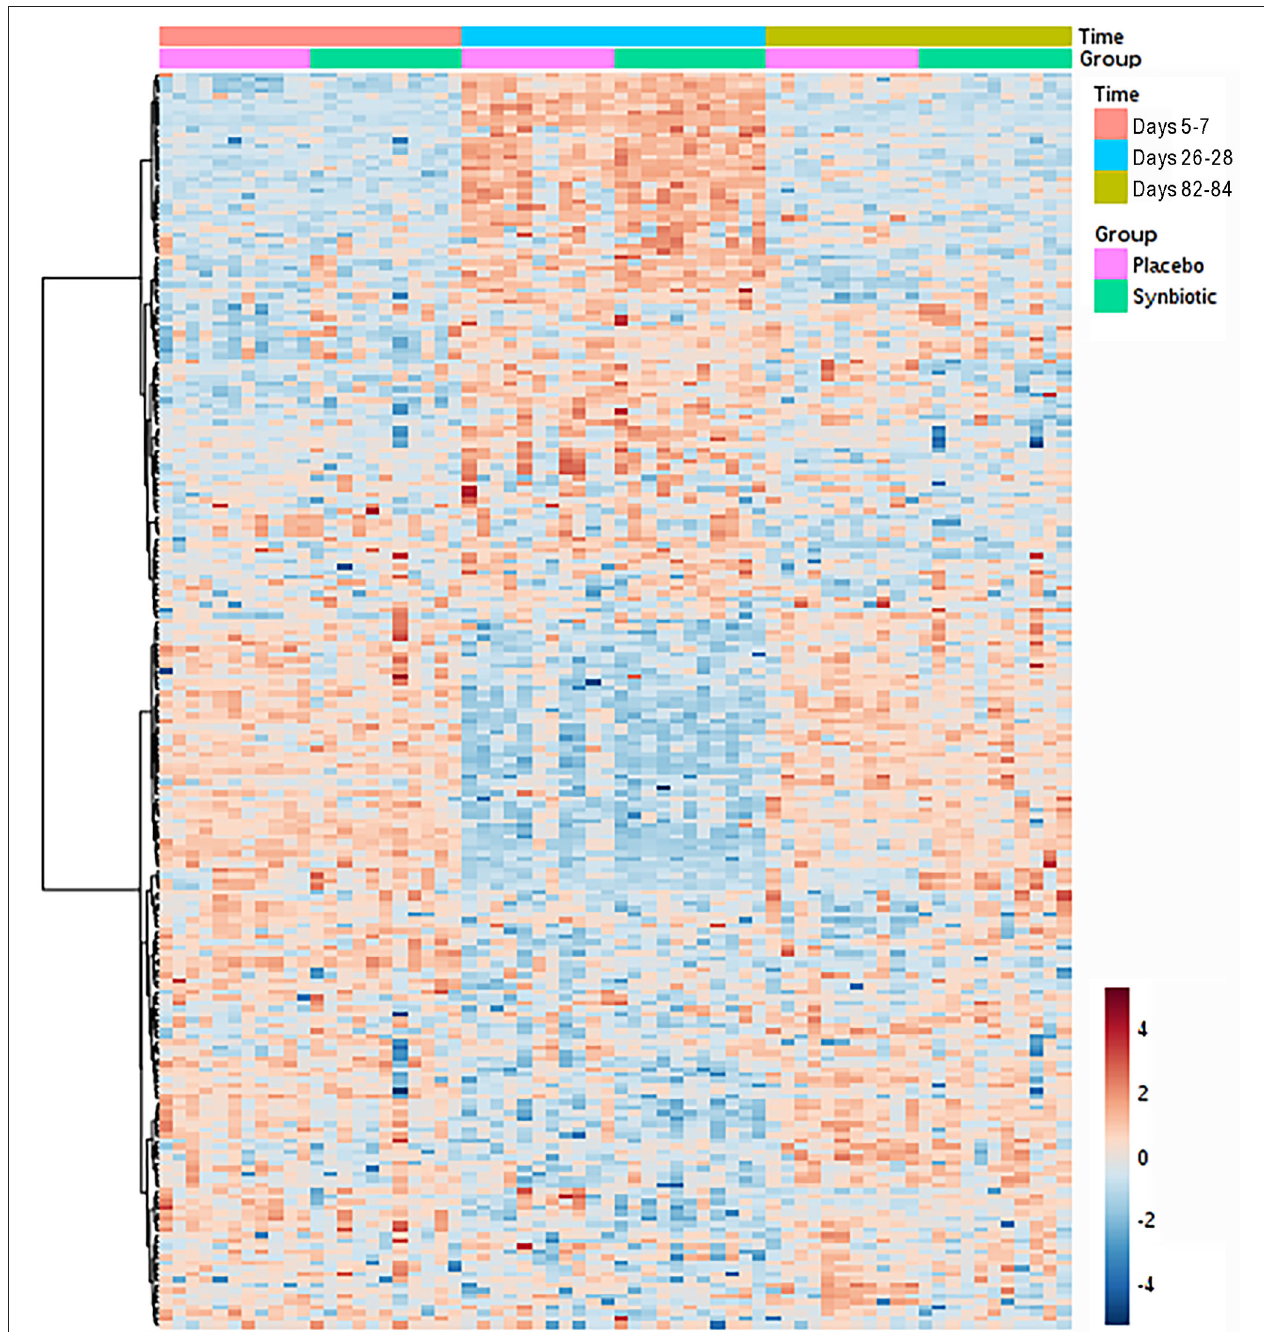
FIGURE 4 | Dual hierarchical dendrogram of fecal metabolites, clustered by pathway, that differed significantly over time for dogs that received enrofloxacin/ metronidazole followed by placebo or synbiotic for 21 days.